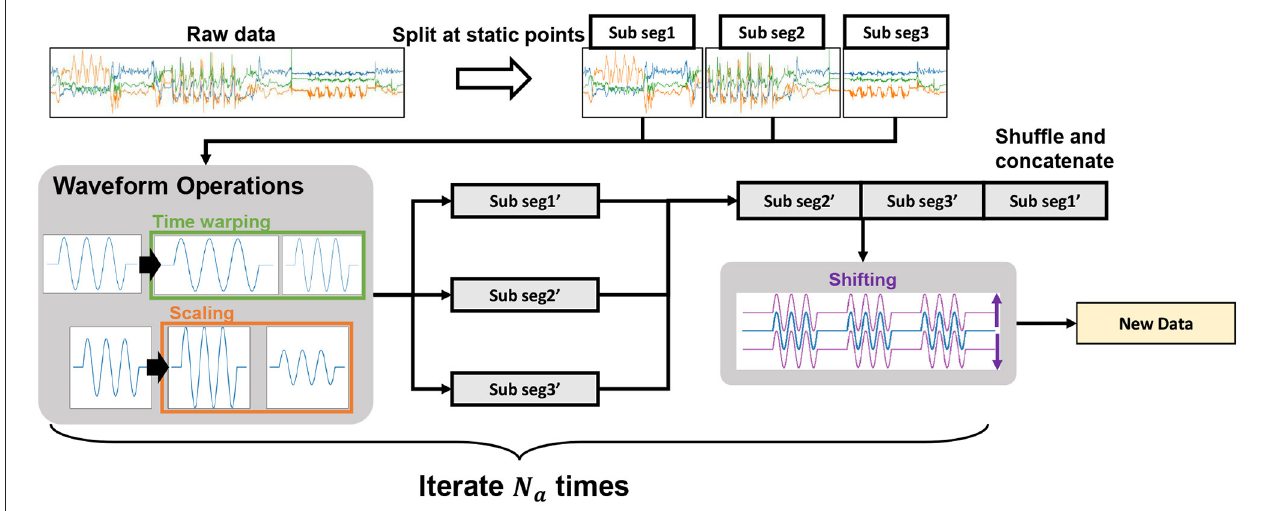
FIGURE 4 | Procedure of data